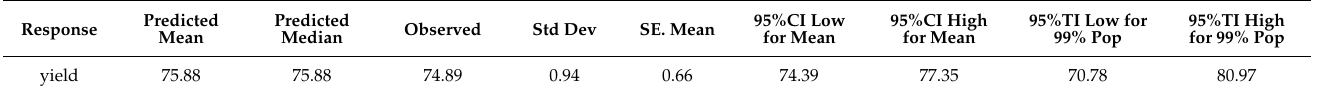
Table 4. Confidence and prediction interval ANOVA analysis